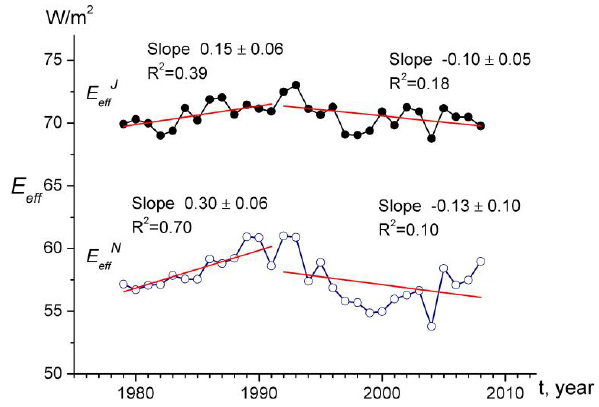
Figure 4. The temporal variability of effective radiation E eff over ATR using JRA-25 reanalysis data for the period from 1979 to